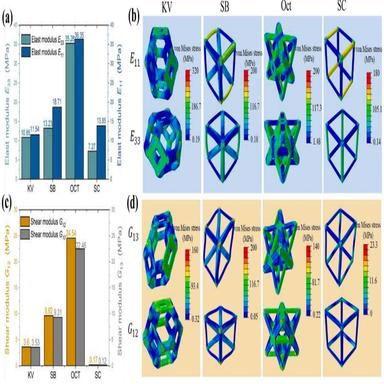
Transversely isotropic elastic behavior of 3d printed lattices. (a) Elastic modulus, (b) Deformation states under uniaxial compression, (c) Shear modulus, (d) Deformation states under shear deformation.